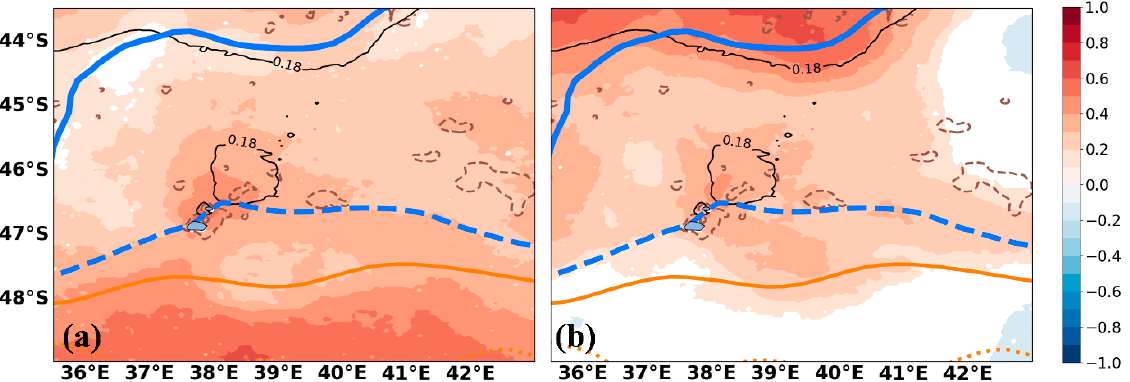
Figure 6. Pearson correlation between monthly mean chlorophyll a and ( a ) Photosynthetically Available Radiation, and ( b ) Sea Surface Temperature, over 1997–2020 period. The dashed brown contours show the 1000 m isobath. The black contours illustrate the long-term mean 0.18 mg m − 3 chla isopleths. The solid and dashed thick blue lines show the long-term mean positions of the middle (M-SAF) and southern (S-SAF) branches of the sub-Antarctic Front, respectively. The solid and dotted thick orange lines illustrate the long-term mean positions of the northern (N-APF) and middle (M-APF) branches of the Antarctic Polar Front, respectively.